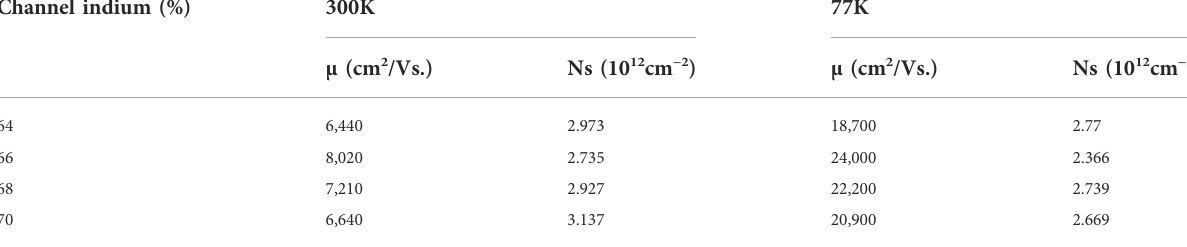
TABLE 1 The 2-deg properties with different channel indium contents at 300K (77K). Channel indium